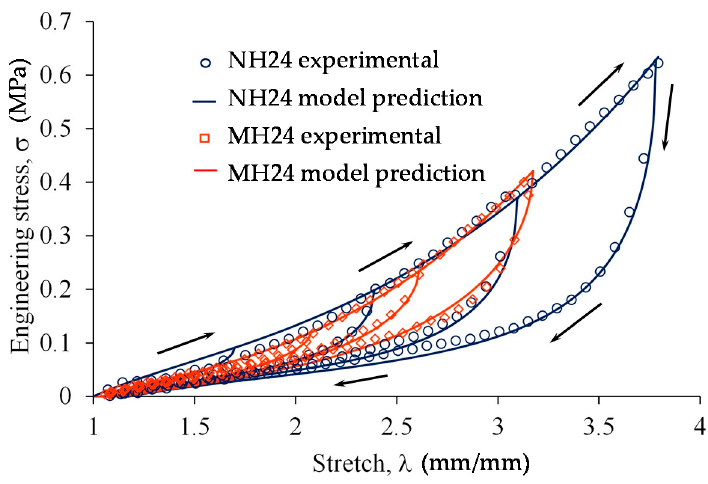
Figure 5. Uniaxial cyclic test for MH24 and NH24 samples, dots are from experimental data and the continuous line is the mathematical model representation. The arrows indicate the direction of load and unload cycle. Table 3. Material constants used to fit the cyclic experimental data.